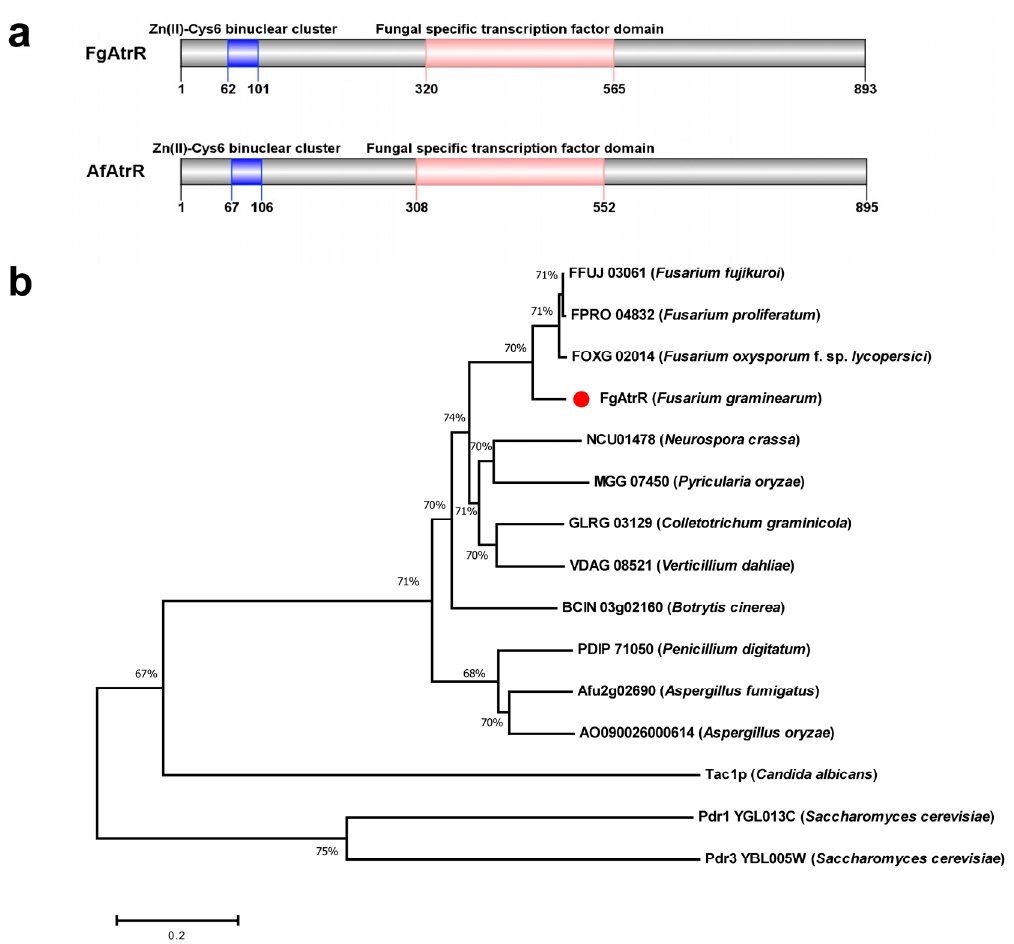
Figure 1. Domain structures and phylogenetic analysis. ( a ) Protein domains of FgAtrR and AfAtrR found in the Pfam database are shown. ( b ) The phylogenetic tree based on the amino acid sequence was constructed by the MEGA-X program using the neighboring-join method. The amino acid sequences from different species (shown in brackets) were aligned by MUSCLE.